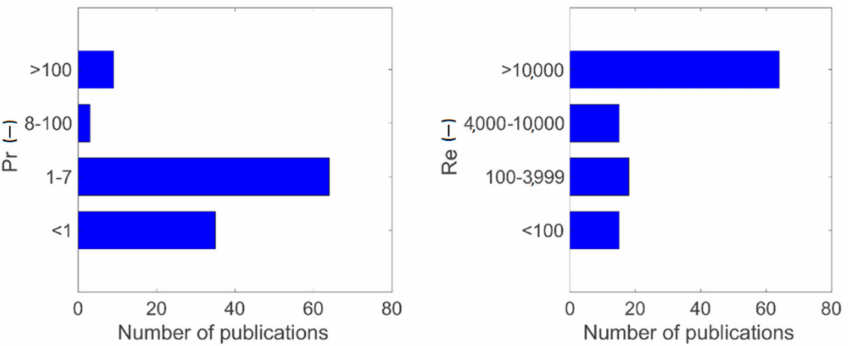
Figure 1. Overview of publications dealing with passive inserts classified into Reynolds and Prandtl number range.